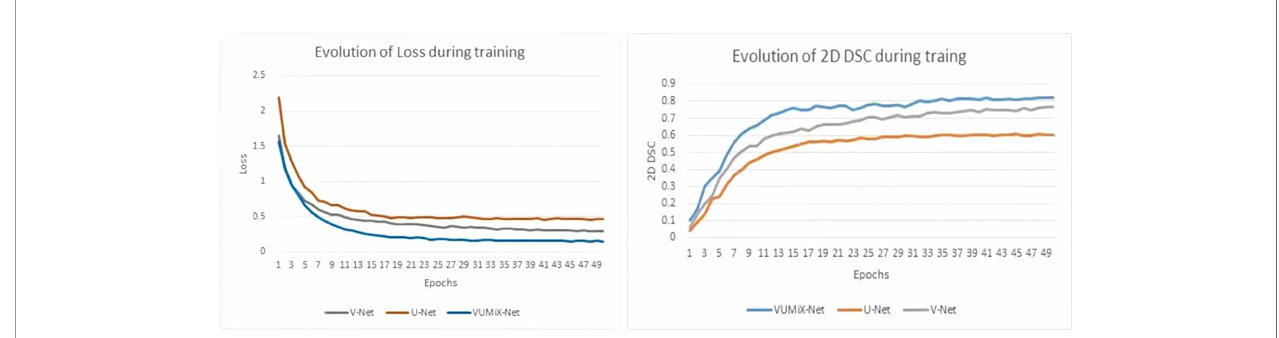
FIGURE 3 | The training DSC and loss of function.